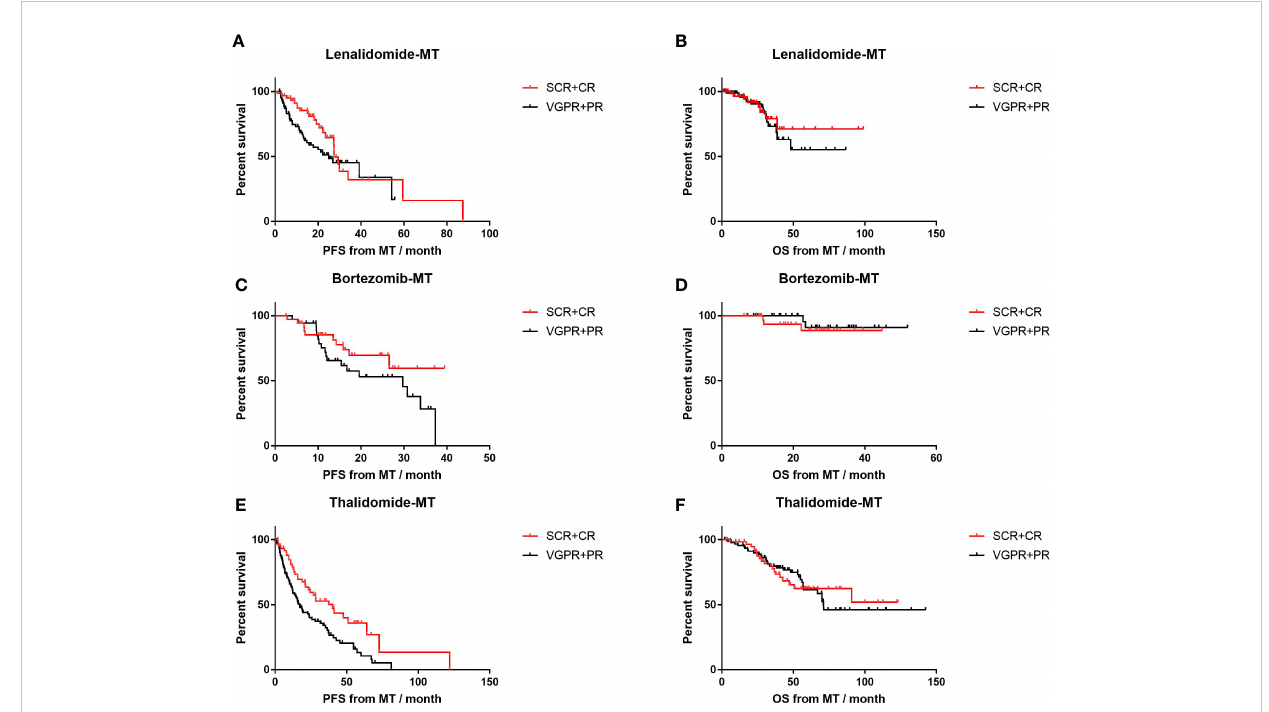
FIGURE 3 Impact of front-line response depth on progression-free survival (PFS) and overall survival (OS) of lenalidomide, bortezomib, and thalidomide maintenance. (A, B) The median PFS and median OS of patients with front-line response of sCR or CR (n=61) versus front-line response of PR or VGPR (n=80) in patients on lenalidomide maintenance. (C, D) The median PFS and median OS of patients with front-line response of sCR or CR (n=36) versus front-line response of PR or VGPR (n=43) in patients on bortezomib maintenance. (E, F) The median PFS and median OS of patients with front-line response of sCR or CR (n=61) versus front-line response of PR or VGPR (n=94) in patients on thalidomide